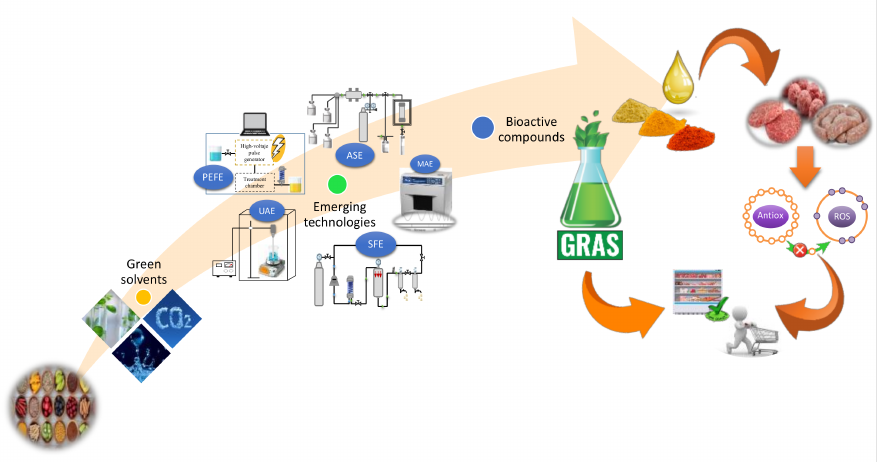
Figure 2. Extraction of BACs by eco-innovative technologies and application as antioxidants in fresh meat and meat